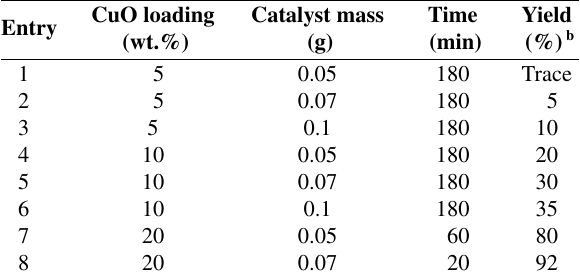
Table 3. Optimization of the reaction